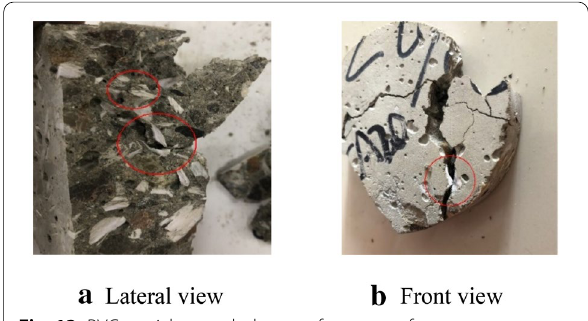
Fig. 13 PVC particle morphology on fracture